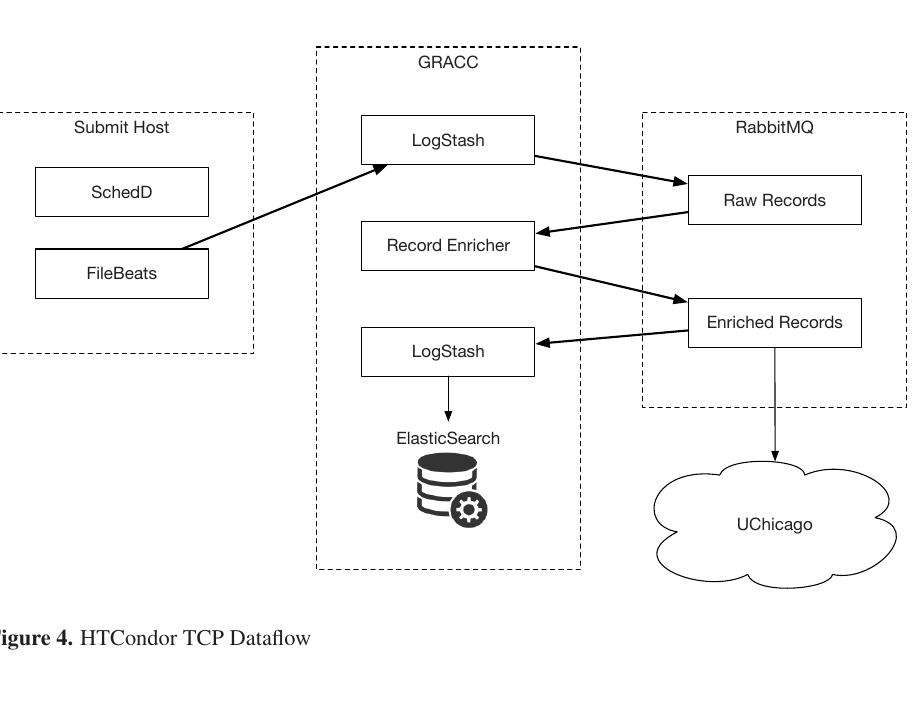
Figure 4. HTCondor TCP